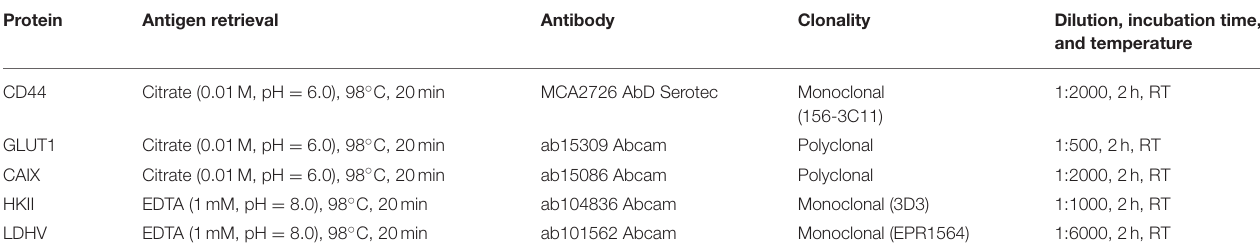
TABLE 2 | Detailed aspects of immunohistochemistry.